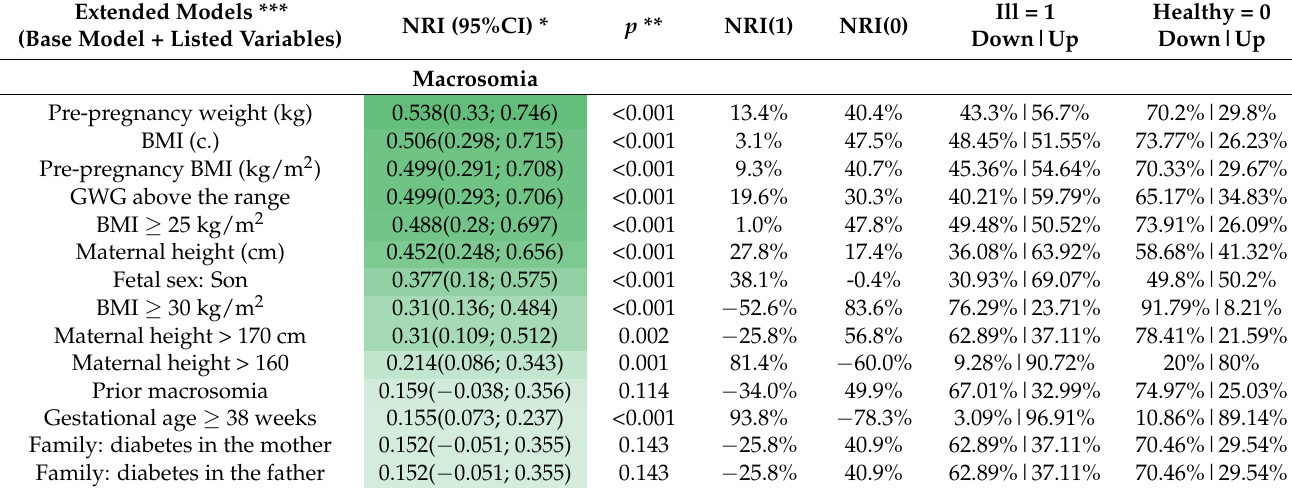
Table 5. Values of NRI in the extended multivariate models for the probability of macrosomia. Extended Models